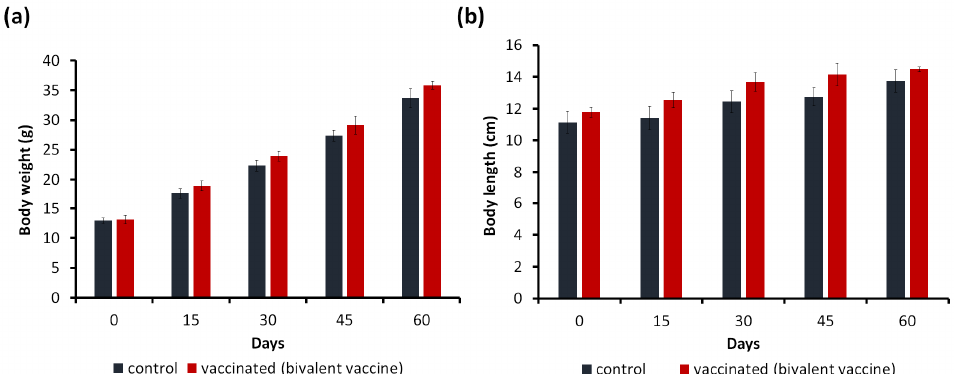
Figure 3. Effects of formulated pallets on the red hybrid tilapia’s growth performance. ( a ) Body weight and ( b ) body length of red hybrid tilapia after 60 days. Results are the average data in triplicate ± standard deviation (error bar). Insignificant differences ( p ≥ 0.05) between control and vaccinated group.The maximum mean final weight was observed in the vaccinated (35.83 ± 1.20 g) compared with the unvaccinated (33.67 ± 0.98 g) groups ( p ≥ 0.05).